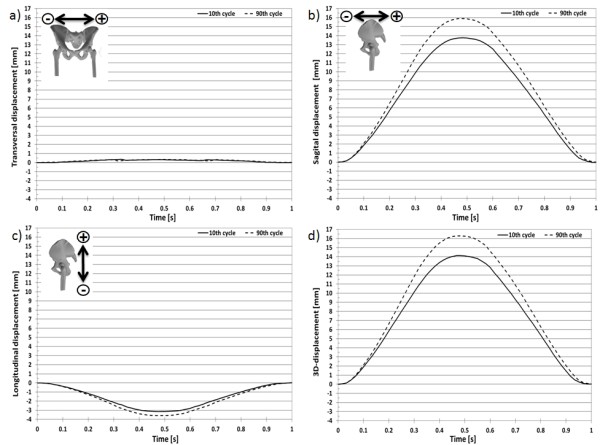
3D-displacement of the back pelvis marker at the iliac crest. 3D-displacement of the back pelvis marker at the iliac crest at the 10th and 90th loading cycle with a sinusoidal load between 100N and 900N.